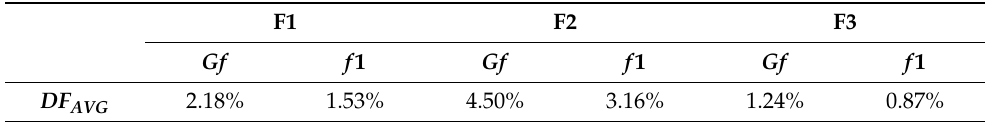
Table 15. Average daylighting factors for G f and f 1 with F1, F2, and F3.